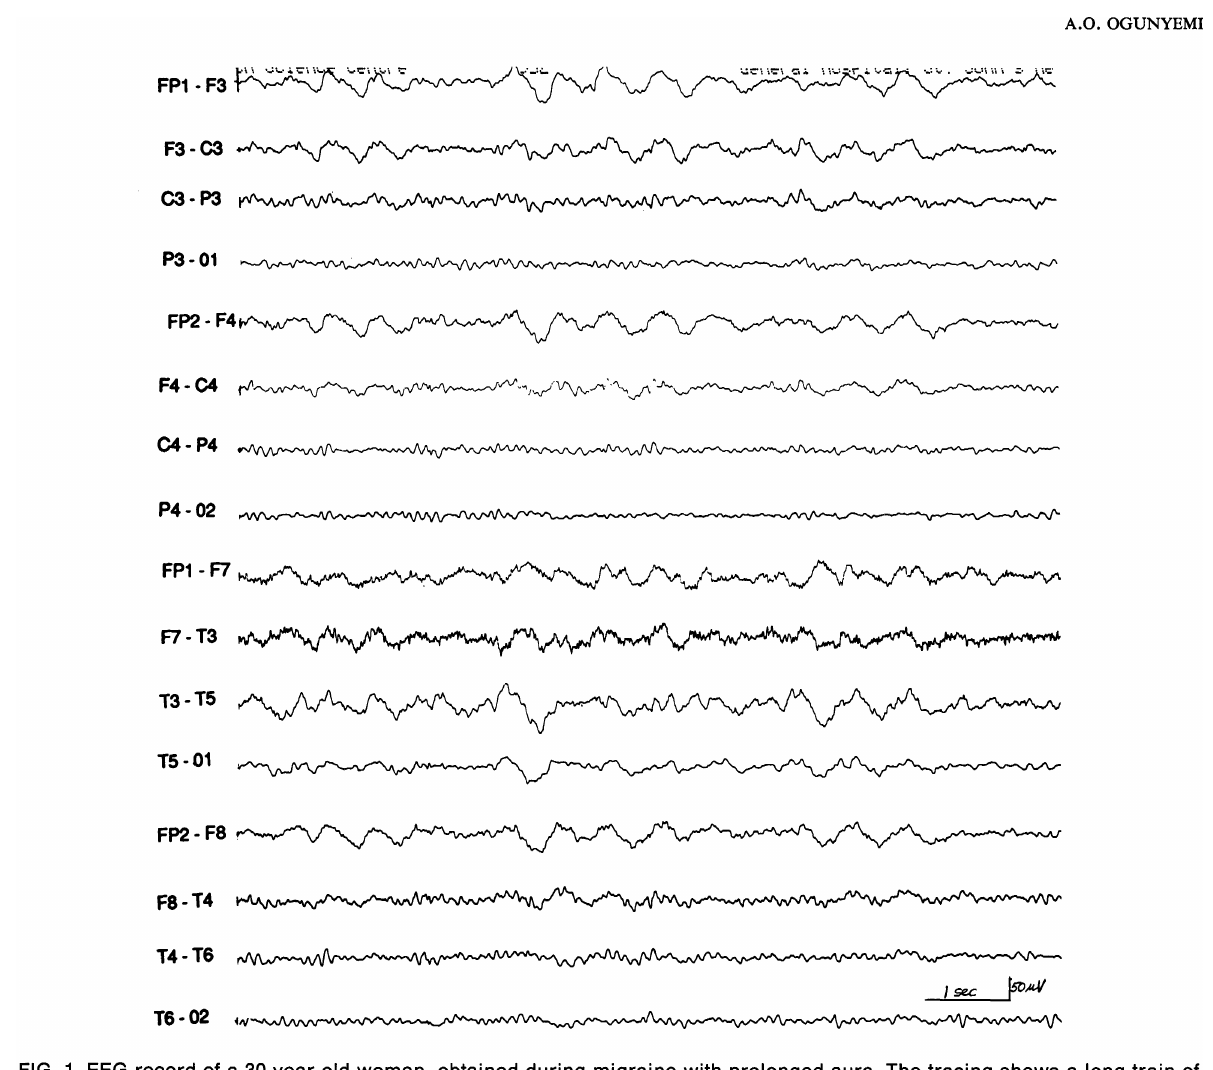
FIG. 1. EEG record of a 30 year old woman, obtained during migraine with prolonged aura. The tracing shows a long train of bilateral frontotemporal slow waves, maximum on the